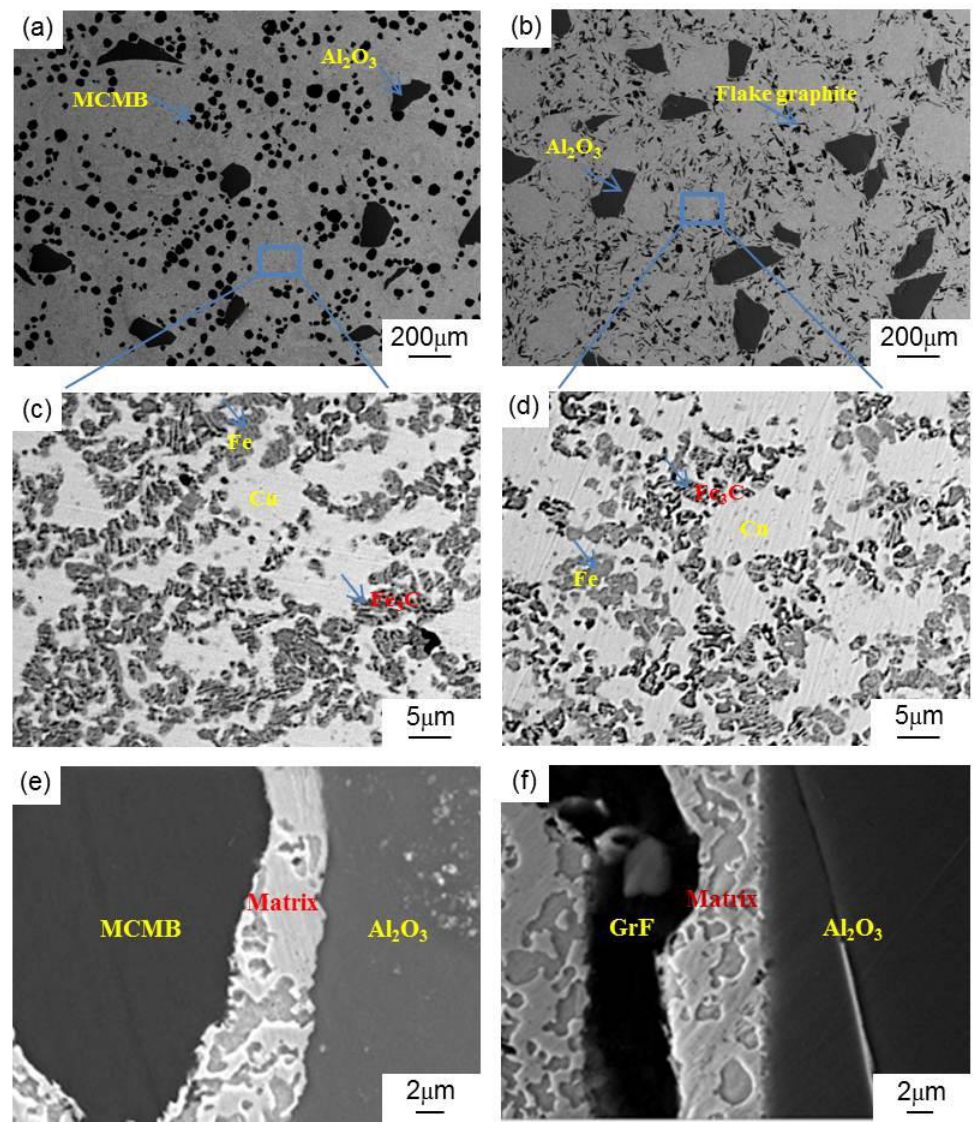
Figure 2. Scanning electron microscopy images (SEM) of the ( a , e ) MCMB-25 and ( b , f ) GrF-25 composites, and the backscatter electron image (BSEM) of the matrices of the ( c ) MCMB-25 and ( d ) GrF-25 composites. Table 2. Densities and porosities of MCMB–Cu composites and GrF–Cu composites.